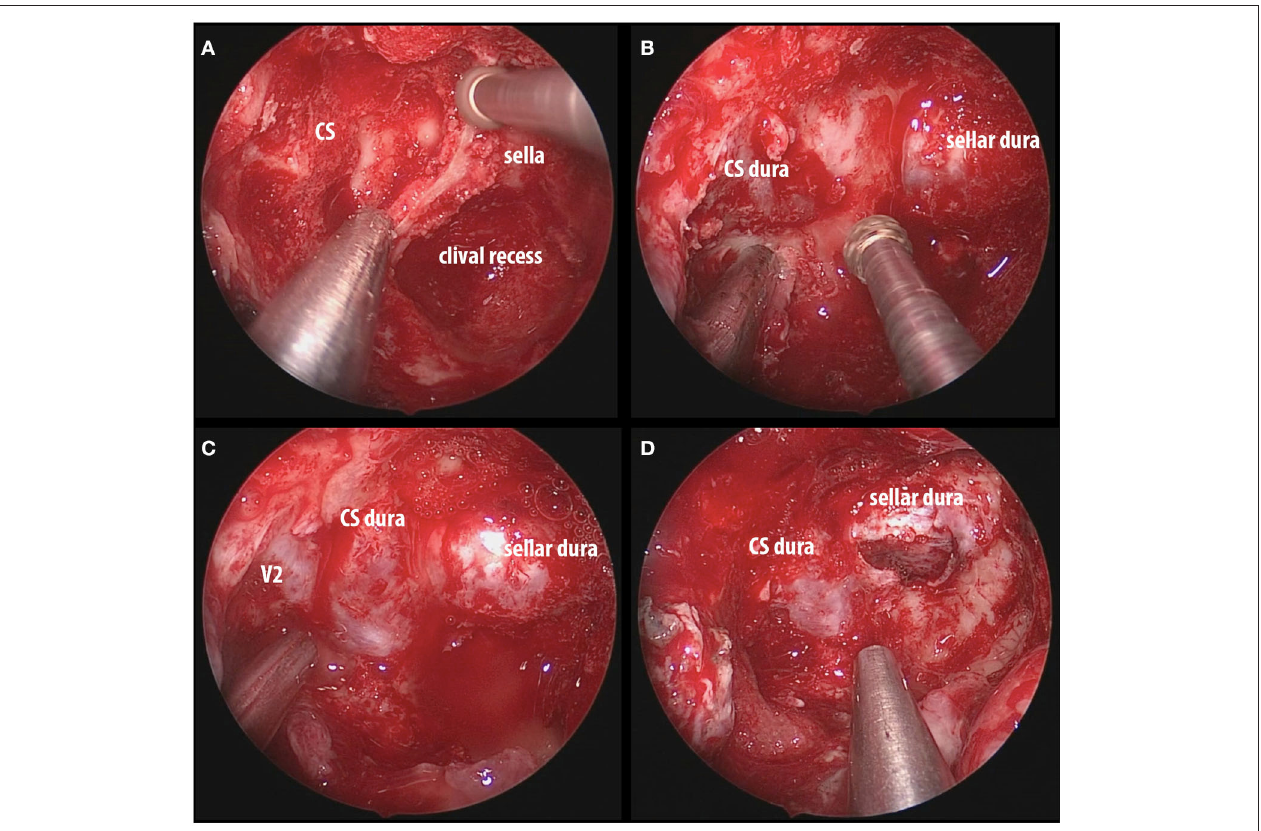
FIGURE 5 | Intraoperative images of endoscopic endonasal decompression for a right side CS meningioma. (A) Drilling down the intersphenoid septum and accessory septa flush with the ventral skull base; (B) exposure of the sellar dura and CS dura with a bridge of bone overlying the cavernous internal carotid artery; (C) complete decompression of the bone overlying the sella, medial SOF, and CS; (D) opening the sellar interdural space (between the periosteal and meningeal layers of dura) that is occupied by the tumor and it is considered one of the safe zones for biopsy. CS, cavernous sinus; SOF, superior orbital fissure; V2, maxillary